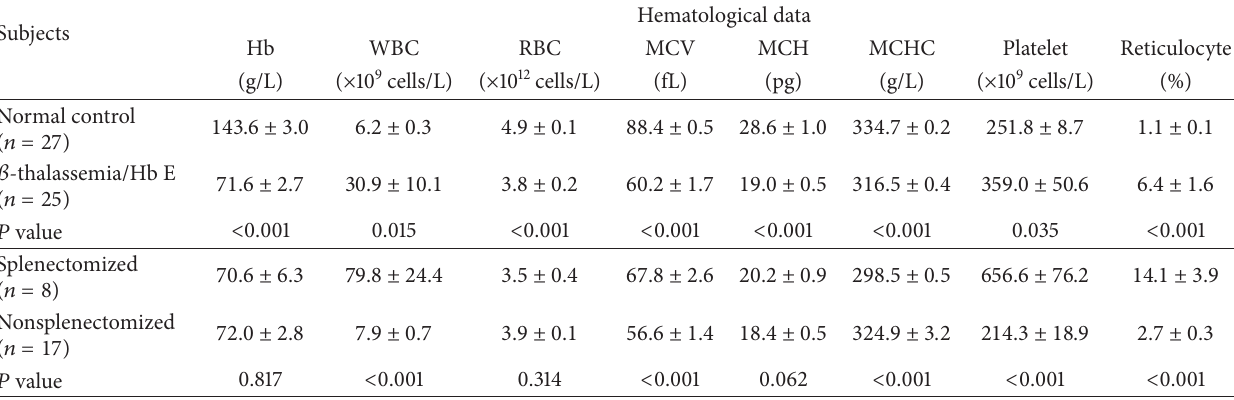
Table 1: Hematological parameters of normal and 𝛽 -thalassemia/Hb E subjects (mean ± SEM).